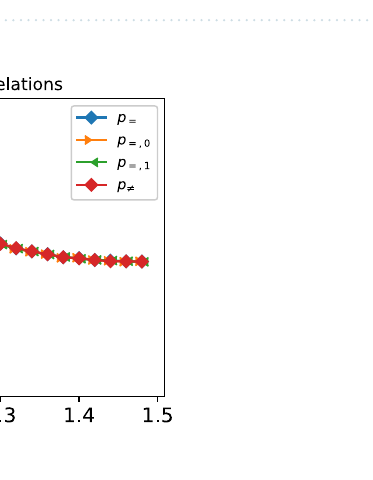
Figure 2. Coordination ratio m i for different values of the aspiration, averaged over agents, time and simulations.